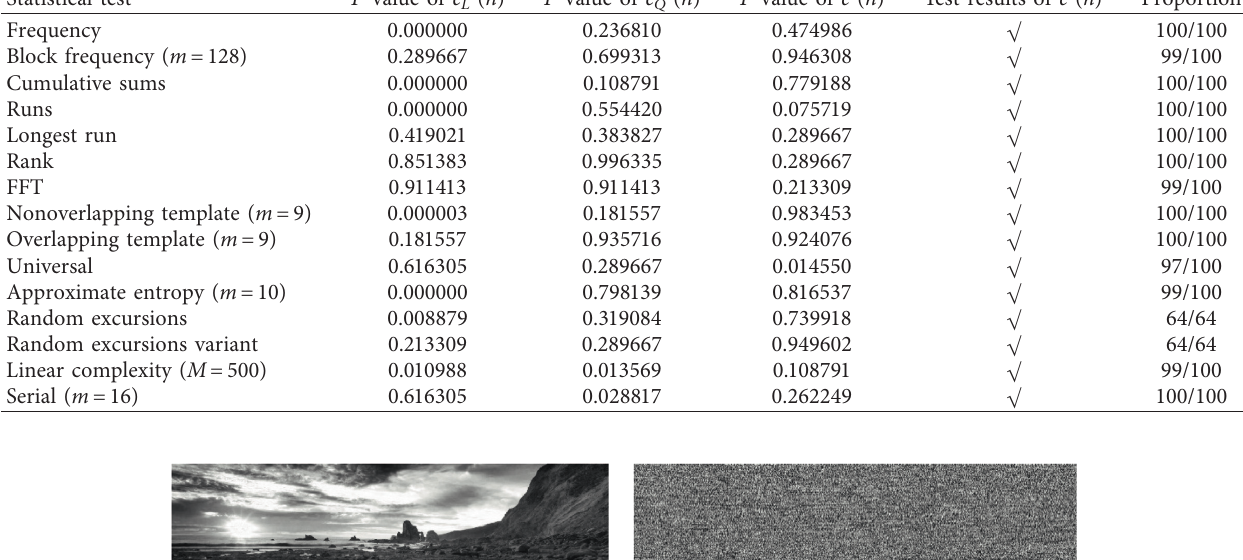
Table 1: NISTtest results for the random sequences of the new system, Lorenz system, and Qi system (the number of sequences is 100, and their lengths are 1000000).